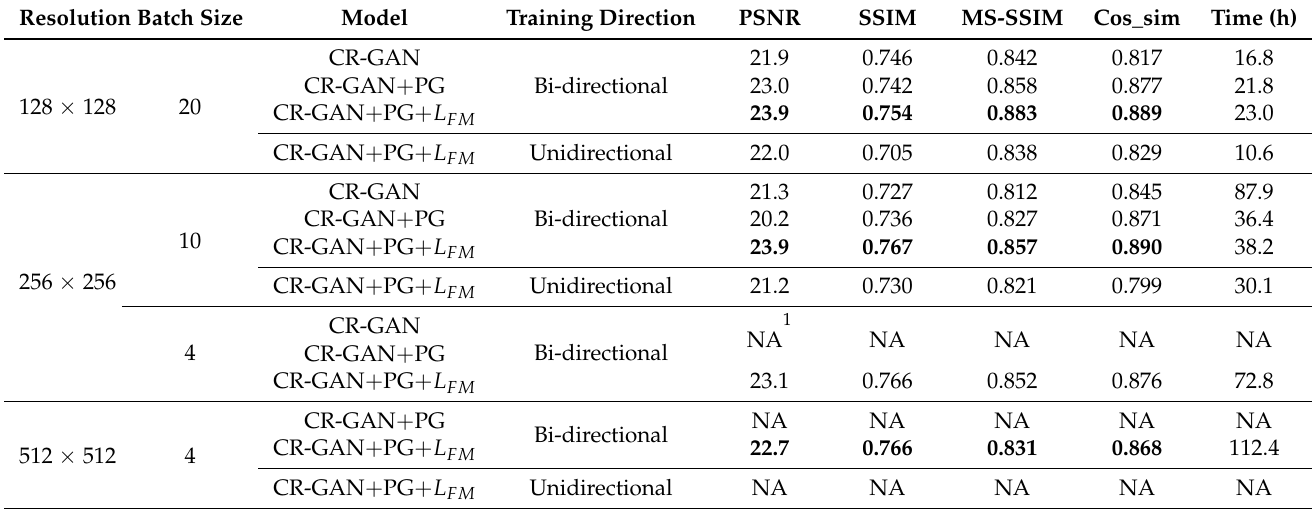
Table 3. Image similarity metrics and training time with respect to the training